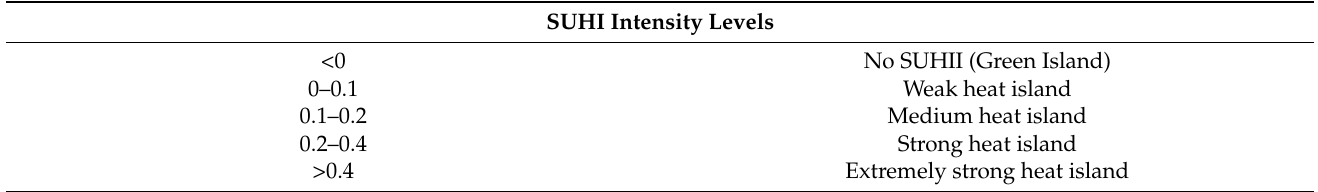
Table 3. Classification of the surface urban heat island intensity (following